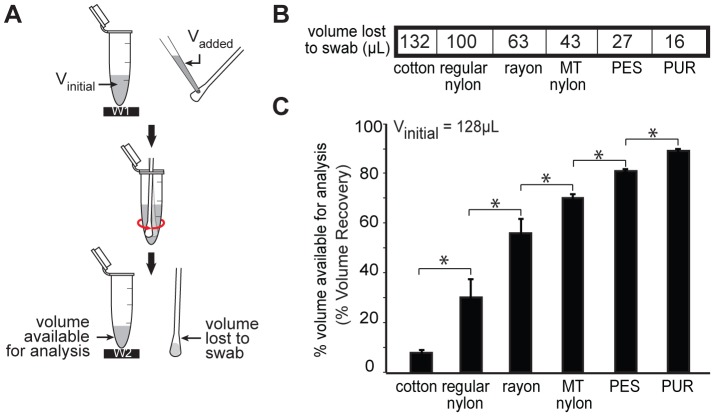
Volume recovery testing.(A) Schematic of the experimental setup. The tube containing 128 µL TE was weighed (W1), and 15 µL TE was pipetted onto the swab, which was then transferred into the tube using 10 second 1 Hz side twirl, and removed. The tube containing the leftover buffer (eluate) was weighed (W2). The % volume available for analysis (% Volume Recovery) was calculated using Equation 3 in the text. (B) Mean TE volume (µL) absorbed by each type of swab (N = 5). (C) Comparison of the % Volume Recovery (mean ± SE; N = 5) from each swab. Calcium alginate swabs were resuspended in 1% w/v sodium citrate buffer to dissolve fibrous tip materials, the % Volume Recovery was not reported here due to density change of the buffer during (A). * indicates significant differences (Tukey-Kramer, α = 0.05).